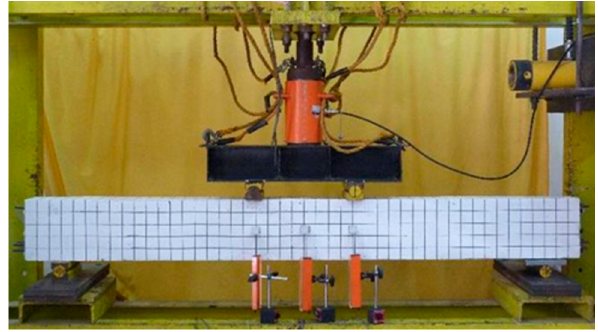
Figure 3. Test setup and equipment used.